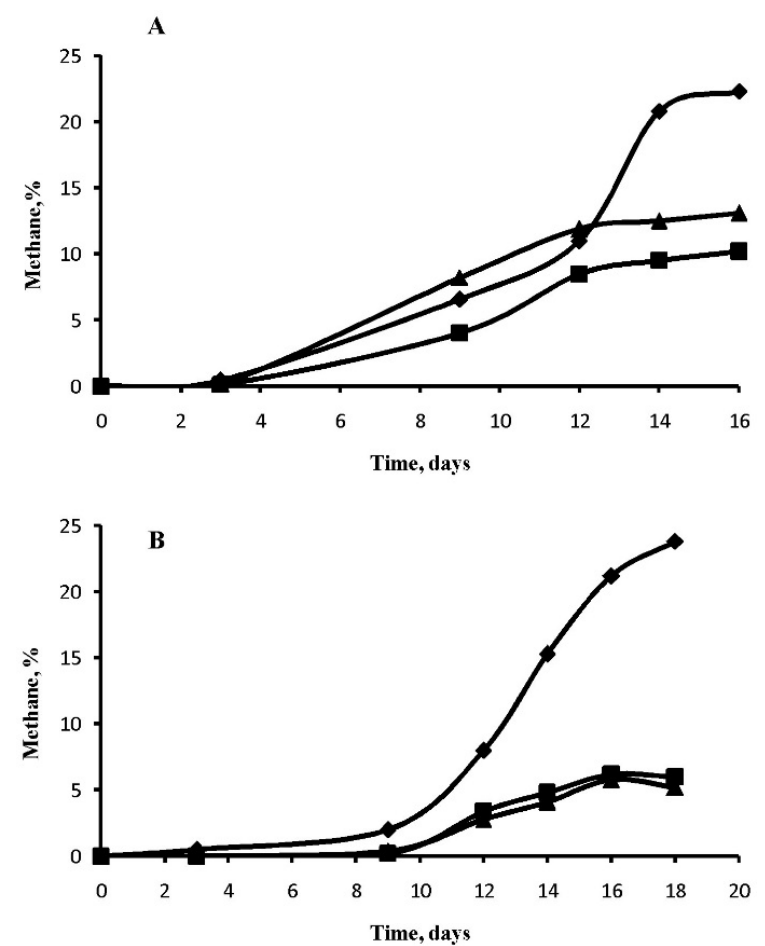
Figure 3. Methane formation by acetoclastic strains M. mazei S-6 T ( A ) and Methanosarcina sp. JL01 ( B ) with NaClO 4 (square), Mg(ClO 4 ) 2 (triangle) and without perchlorates